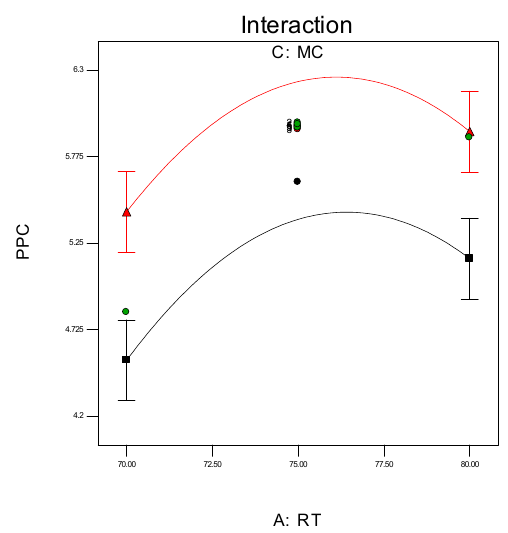
Figure 12. ( a ) Interaction between temperature and pressure; ( b ) Interaction between temperature and propylene concentrations; ( c ) Interaction between pressure and propylene concentration.